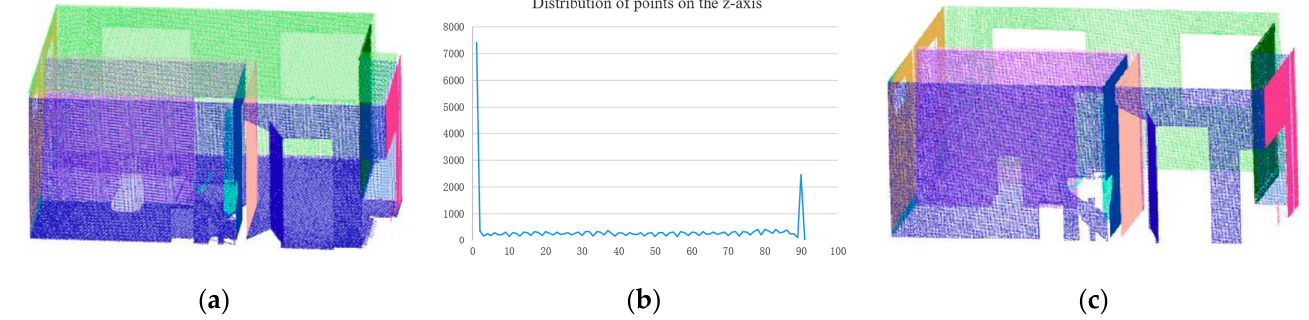
Figure 2. Extraction result of wall. ( a ) Scene segmentation; ( b ) distribution of z coordinate; ( c ) wall partition.